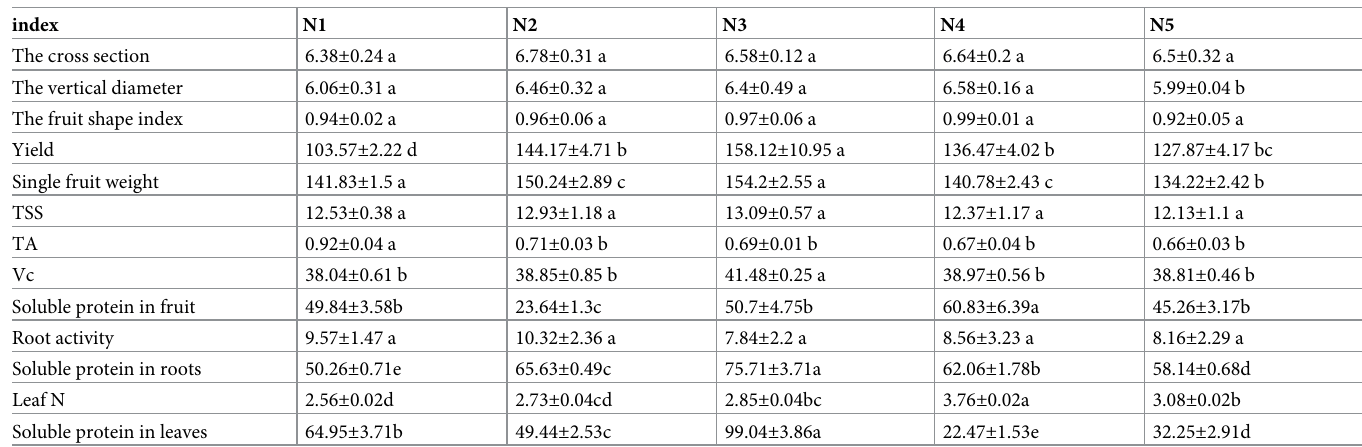
Table 6. Effects of different N levels on the cross section (cm), the vertical diameter (cm), the fruit shape index, yield (kg/plant), single fruit weight (g), total soluble solids (TSS, %), total acid (TA, g/100 mL), vitamin C (Vc, mg/100 mL), soluble protein in fruit, root activity, soluble protein in roots, leaf N, and soluble protein in leaves of ‘Huangguogan’. Data are means ± SD of five replicates. Different lowercase letters indicate significant differences ( P < 0.05) among treatments.